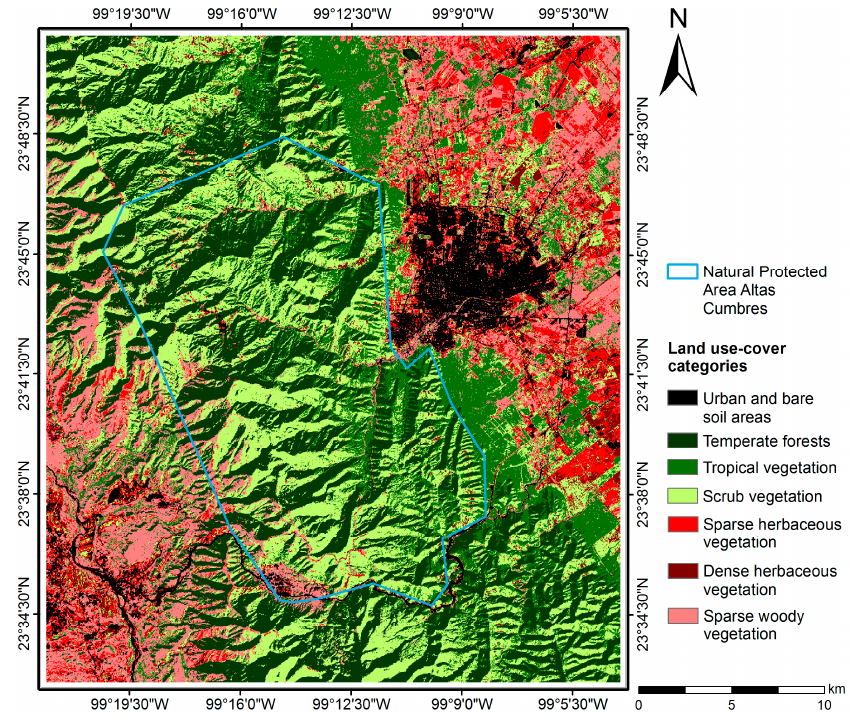
Figure A3. Land use-cover in 2000, Natural Protected Area Altas Cumbres and adjacent area. Victoria, Tamaulipas, Mexico.